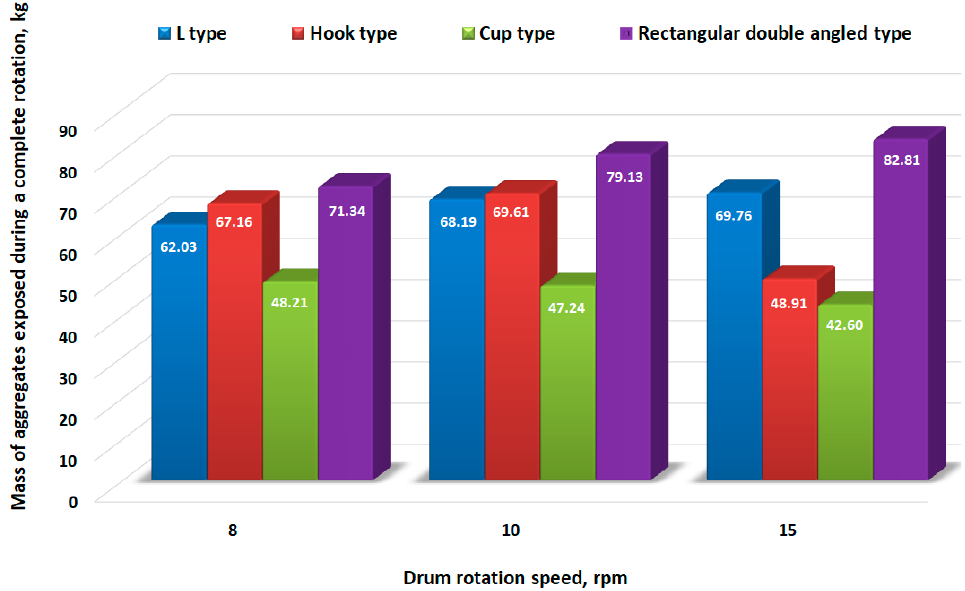
Figure 7. The influence of flight shape on the mass of aggregates exposed to drying during a complete rotation for 15% drum filling degree.